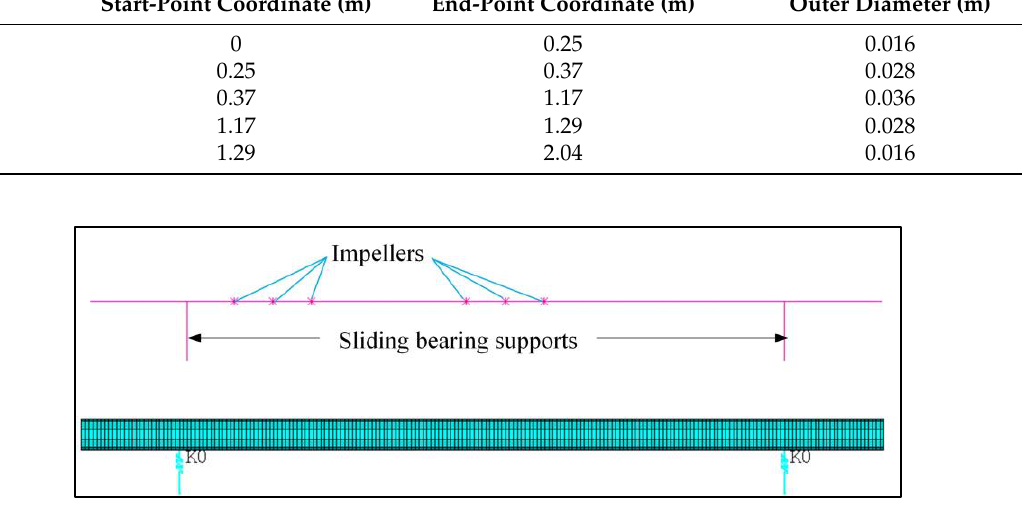
Figure 10. The finite element model of the multi-stage centrifugal pump rotor system. Table 2. The specific parameters of the impellers.